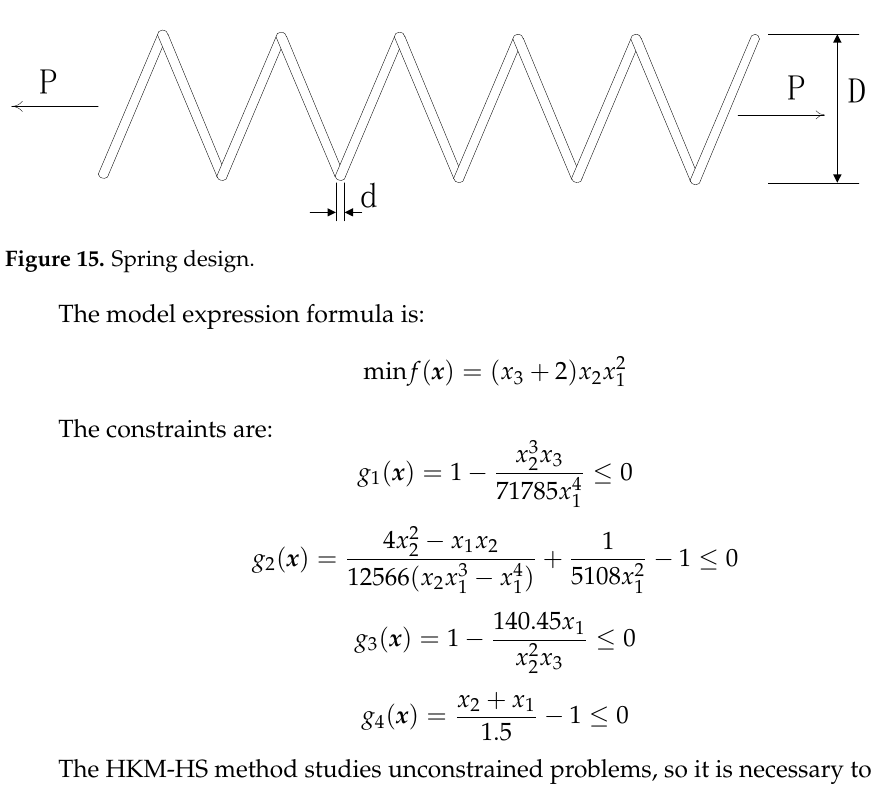
( b ) Figure 14. ( a ) Box plot of test results for Hartman6 function; ( b ) Box plot of test results for F16 function. The RMSE results of 10 benchmark functions with different dimensions tested using HKM-HS, AME, MMSE and LHD algorithms are listed in Table 5. Table 5 concluded that in the test of 10 benchmark functions, the test result of 8 functions showed that the HKM-HS algorithm has the smallest average value of RMSE. For the Levy function, the LHD method has the smallest average value and standard deviation of RMSE. The AME algorithm has a better result in the DixonPrice function. The test results of these four methods were compared, and the comparison results show that the accuracy and stabil- ity of the HKM-HS method is slightly higher than the other three methods. The Levy and DixonPrice benchmark functions belong to the first and second types of functions, instead of focusing on one type of function. This shows that the method proposed in this paper is applicable to various types of functions. Figures 10–14 also